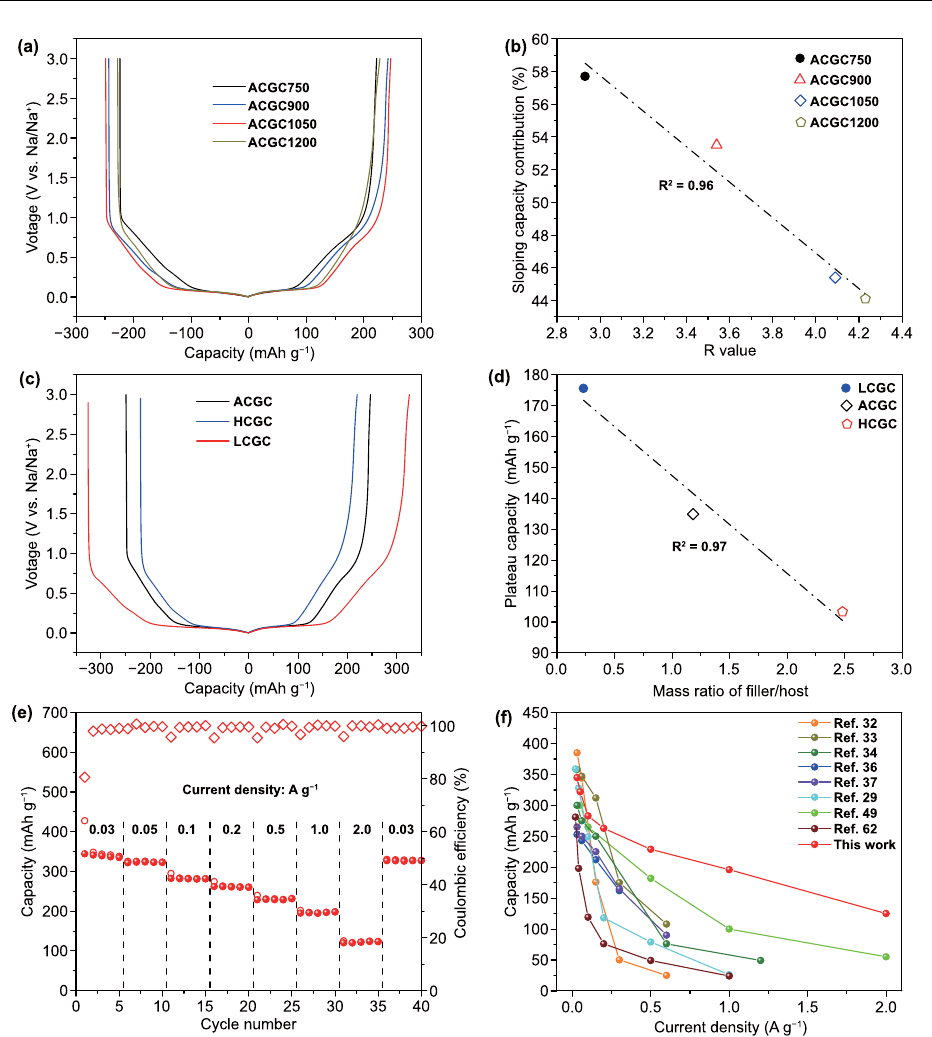
Fig. 3 Effects of carbonization temperature and pore volume on the electrochemical performance: a Galvanostatic discharge/charge curves of ACGCx at 50 mA g −1 , and b the relationship between the sloping capacity contribution and the calculated R value from XRD. c Galvanostatic discharge/charge curves of ACGC, HCGC, LCGC electrodes at 50 mA g −1 . d The relationship between the plateau capacity and the mass ratio of the filler/host. e rate performance and f the comparison of the rate performance of LCGC anode with that of hard carbon anodes recently reported in